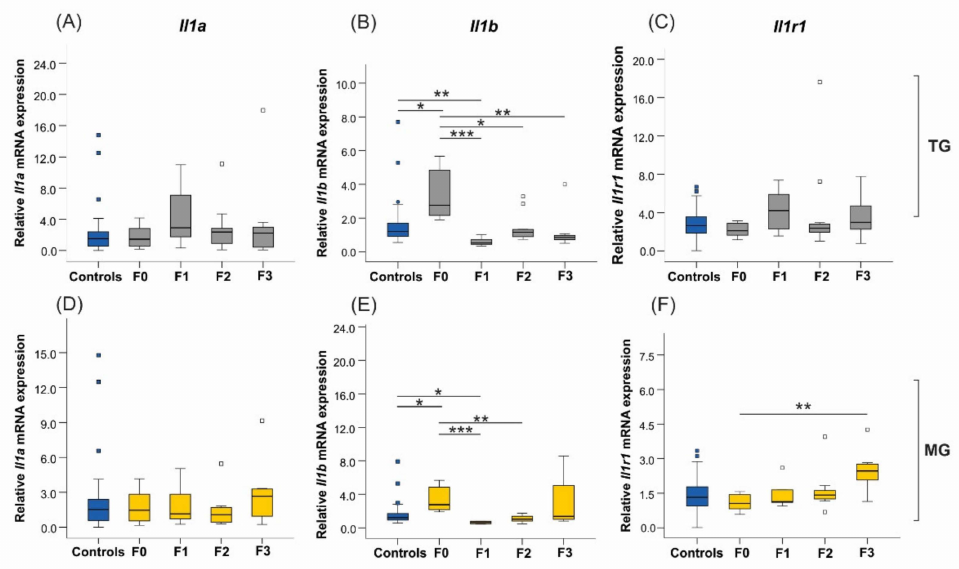
Figure 7. The uterine expression of the Il1b proinflammatory cytokine and the Il1r1 receptor was significantly altered across generations in TG and MG stressed animals. Results from TG and MG groups will be presented alongside each other to compare the effects of stress between the two cohorts. ( A , D ) Expression levels of Il1a were unaffected in both TG and MG groups. ( B ) The abundance of Il1b doubled in the F0 generation and decreased significantly in F1–F3 offspring. Similarly, ( E ) MG-stressed rats presented similar Il1b uterine mRNA expression patterns as the TG dams, with significantly increased expression in F0 and a drop in the F1 and F2 generations. The Il1r1 receptor was significantly upregulated in the F3 uteri of the MG group ( F ), while its expression was unaffected in all generations of the TG group ( C ). Cyclophilin A ( Ppia ) was our reference gene. Asterisks indicate significance: * p < 0.05; ** p < 0.01; *** p < 0.001. Controls n = 20–31; F0 n = 8–10; F1 n = 5–8, F2 + F3 n = 4–12. Box plots mid-lines indicate medians, whiskers indicate min-max values, and boxes indicate interquartile